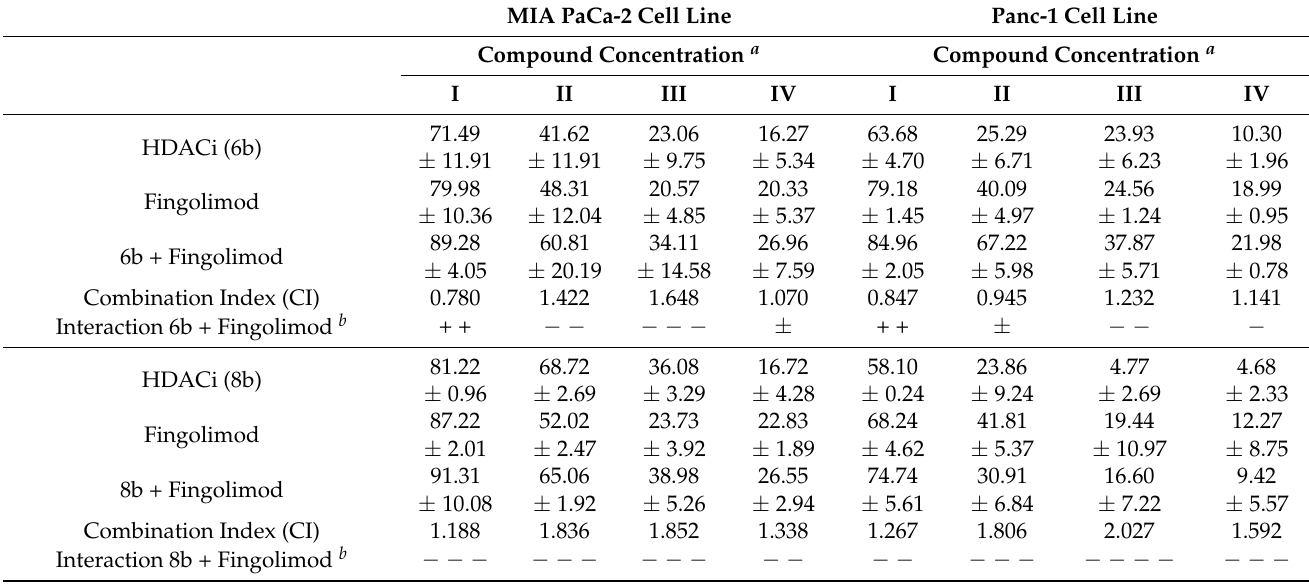
Table 4. Synergism analysis for combination of novel HDACi and